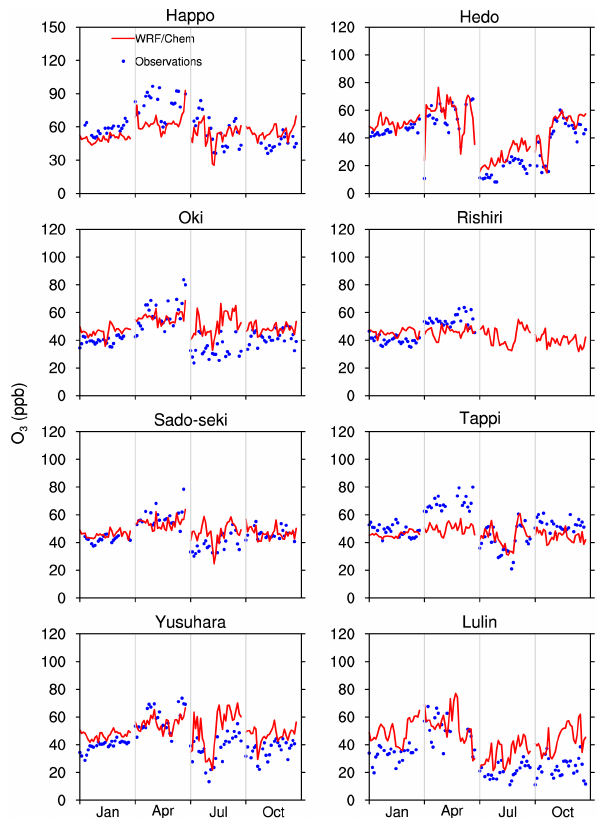
Figure 8. Comparisons of observed (blue dots) and modeled (red lines) daily mean O 3 (ppbv) at seven sites in Japan and one site in